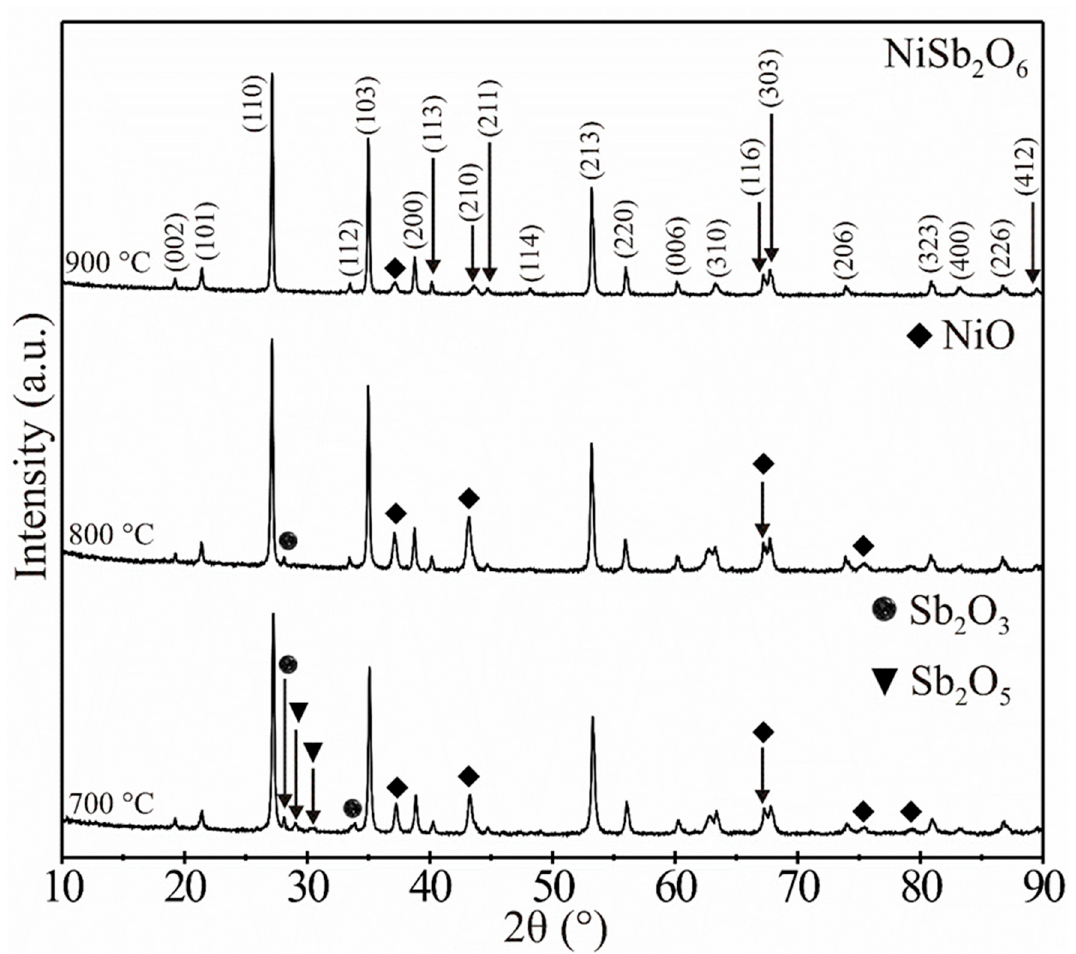
Figure 3. X-ray diffraction patterns of NiSb 2 O 6 calcined at 700, 800, and 900 °C in air.